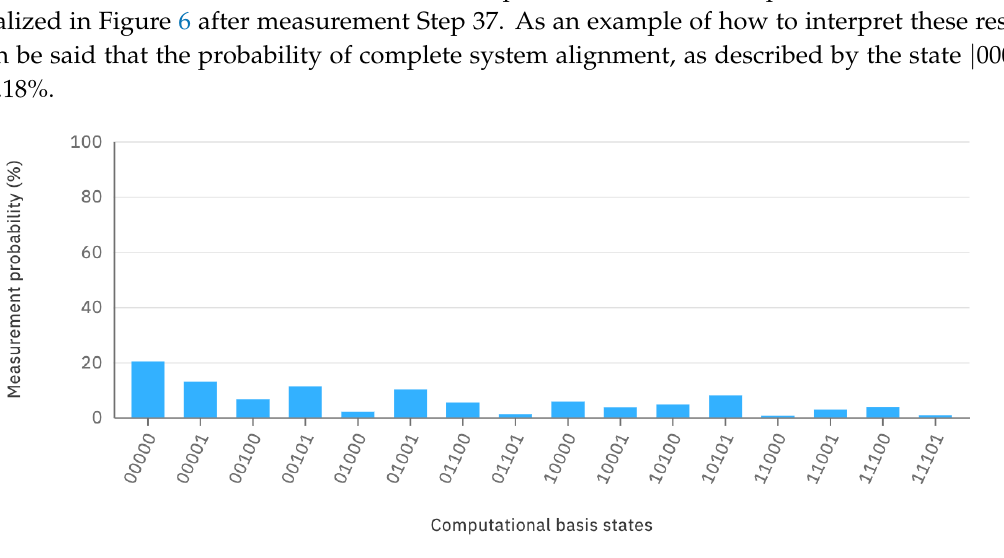
Figure 6. QSOD final Measurement Probabilities in step